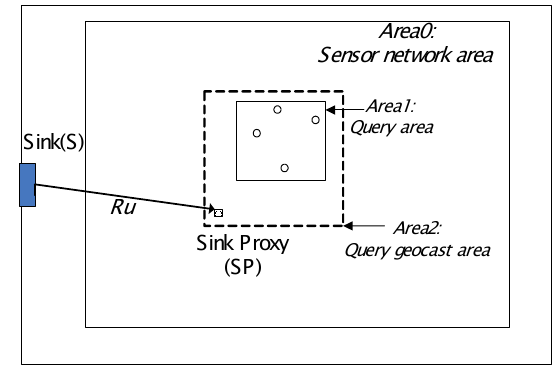
Figure 4 . Selection of effective sink proxy for data